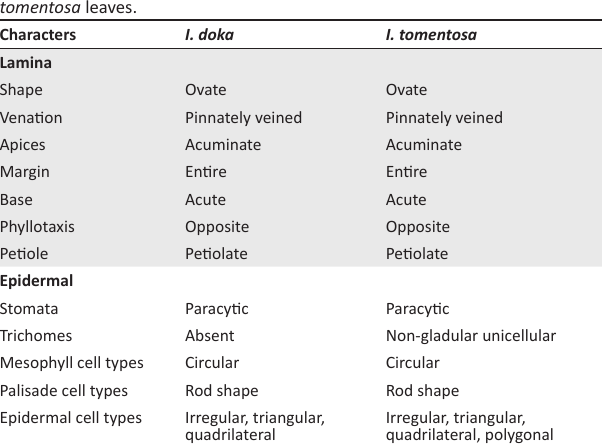
TABLE 3: Qualitative, morphological and anatomical features of I. doka and I. tomentosa leaves.